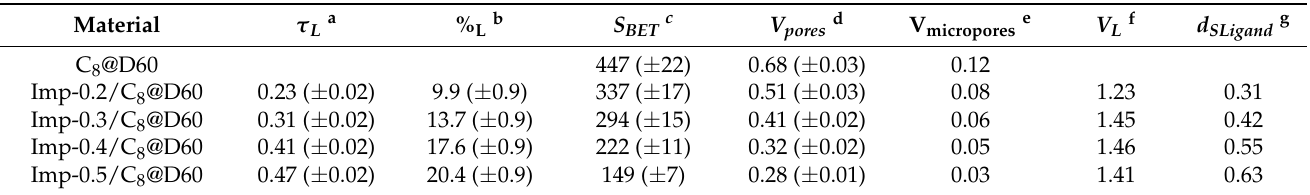
Table 1. Properties of pure silica and the different materials synthesized in this